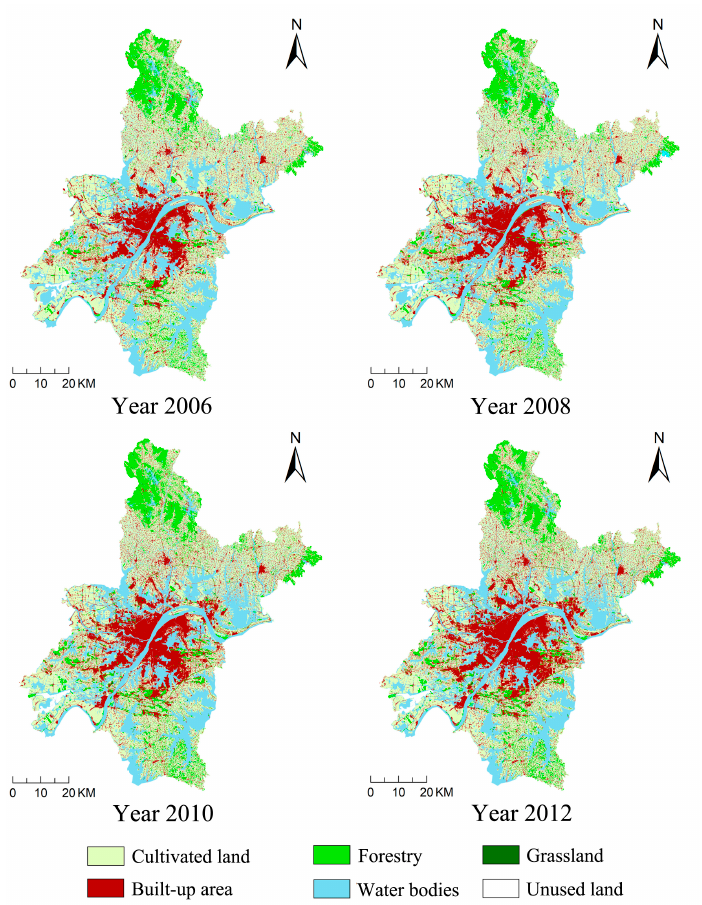
Figure 3. Maps of land use in the study region for the years of 2006, 2008, 2010 and 2012.